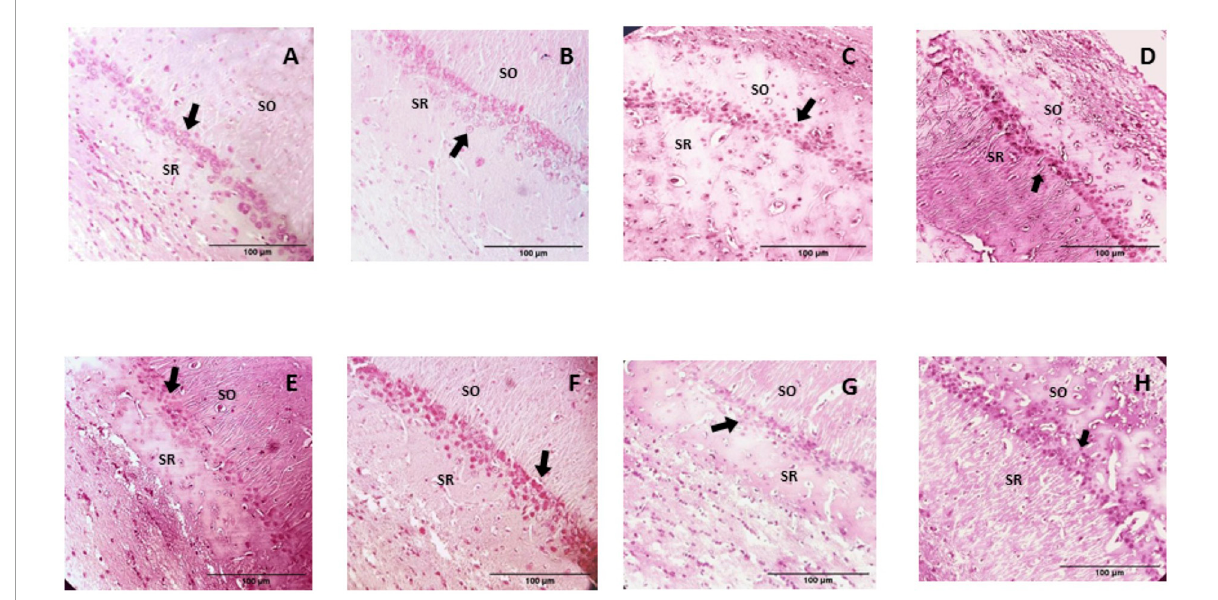
FIGURE7 H-E Staining of the hippocampal CA1 region from study groups. Prob, probiotics; FO, fish oil; SO, stratum oriens; SR, stratum radiatum. (A) Control, (B) Prob, (C) FO, (D) Prob + FO, (E) chocolate, (F) chocolate + Prob, (G) chocolate + FO, (H) chocolate + FO + Prob. The main finding was the observation of apparently smaller nuclei in the pyramidal neurons of hippocampal CA1 region, particularly in the chocolate, chocolate + FO, and FO groups. Arrows point to neuronal nuclei. No damage or degenerative change was observed. Amplification 40x.